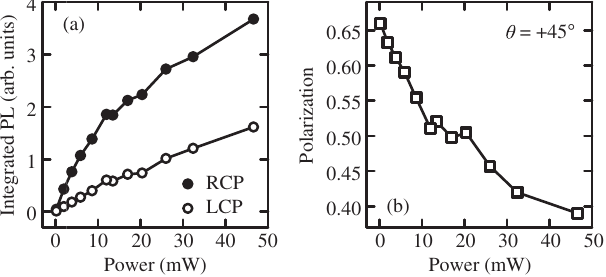
FIG. 2. (a) PL intensity as a function of the laser power for RCP (solid circles) and LCP (open circles), measured at θ ¼ þ 45 ∘ and λ ¼ 780 nm for a CNT with a suspended length of 0 . 9 μ m. (b) Excitation power dependence of the CD polarization calcu- lated from data in (a).